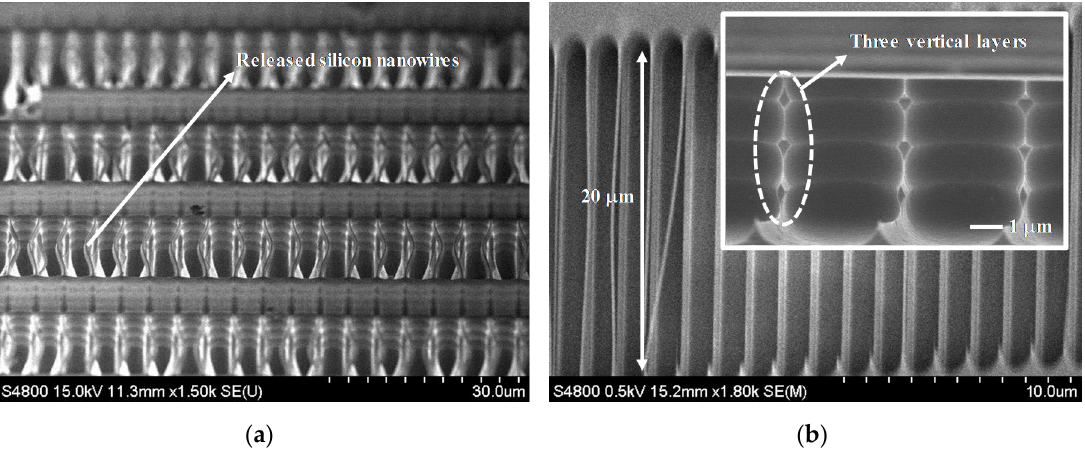
Figure 6. Fabrication result after oxide-layer removal. ( a ) Released silicon-nanowire array; ( b ) top-view and cross-sectional view (inset) of released structure.